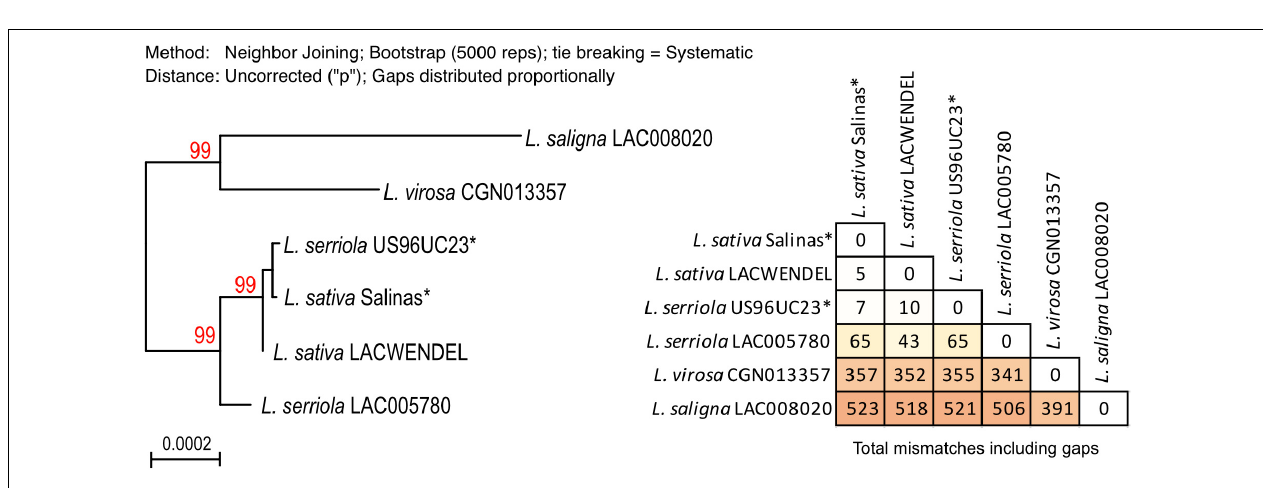
FIGURE 6 | Phylogenetic relation between the plastid genomes of the selected Lactuca species. Maximum likelihood phylogram based on the alignment of the complete cpDNA genomes assembled form the same sequences datasets used to assemble the mitogenomes. Bootstrap values are shown in red and branches with BS < 80 are collapsed. Sequences labeled with an asterisk (*) were assembled with raw reads from Kozik et al. (2019), SRX5097892 ( L. serriola US96UC23) and SRR577192 ( L. sativa cv. Salinas ). The table with the number of SNPs and gaps is